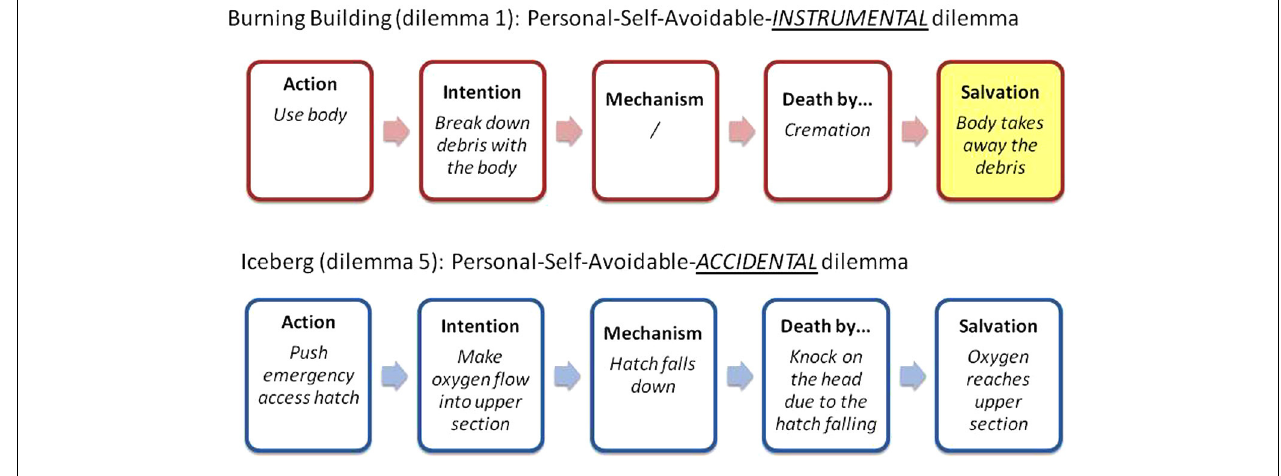
FIGURE 1 | Example of the causal chain of the proposed moral transgression that leads to the salvation. In the Instrumental version of the Burning Building dilemma the proposed action is “to use the body of the victim.” The intention is “use the body to break down burning debris.” The victim dies directly by the fire and there is no independent mechanism in between. A larger number of people are saved due to the fact that the burning debris was eliminated with the victim . The harm to the victim was thus used as a means to save others. Said in different words, the body of the